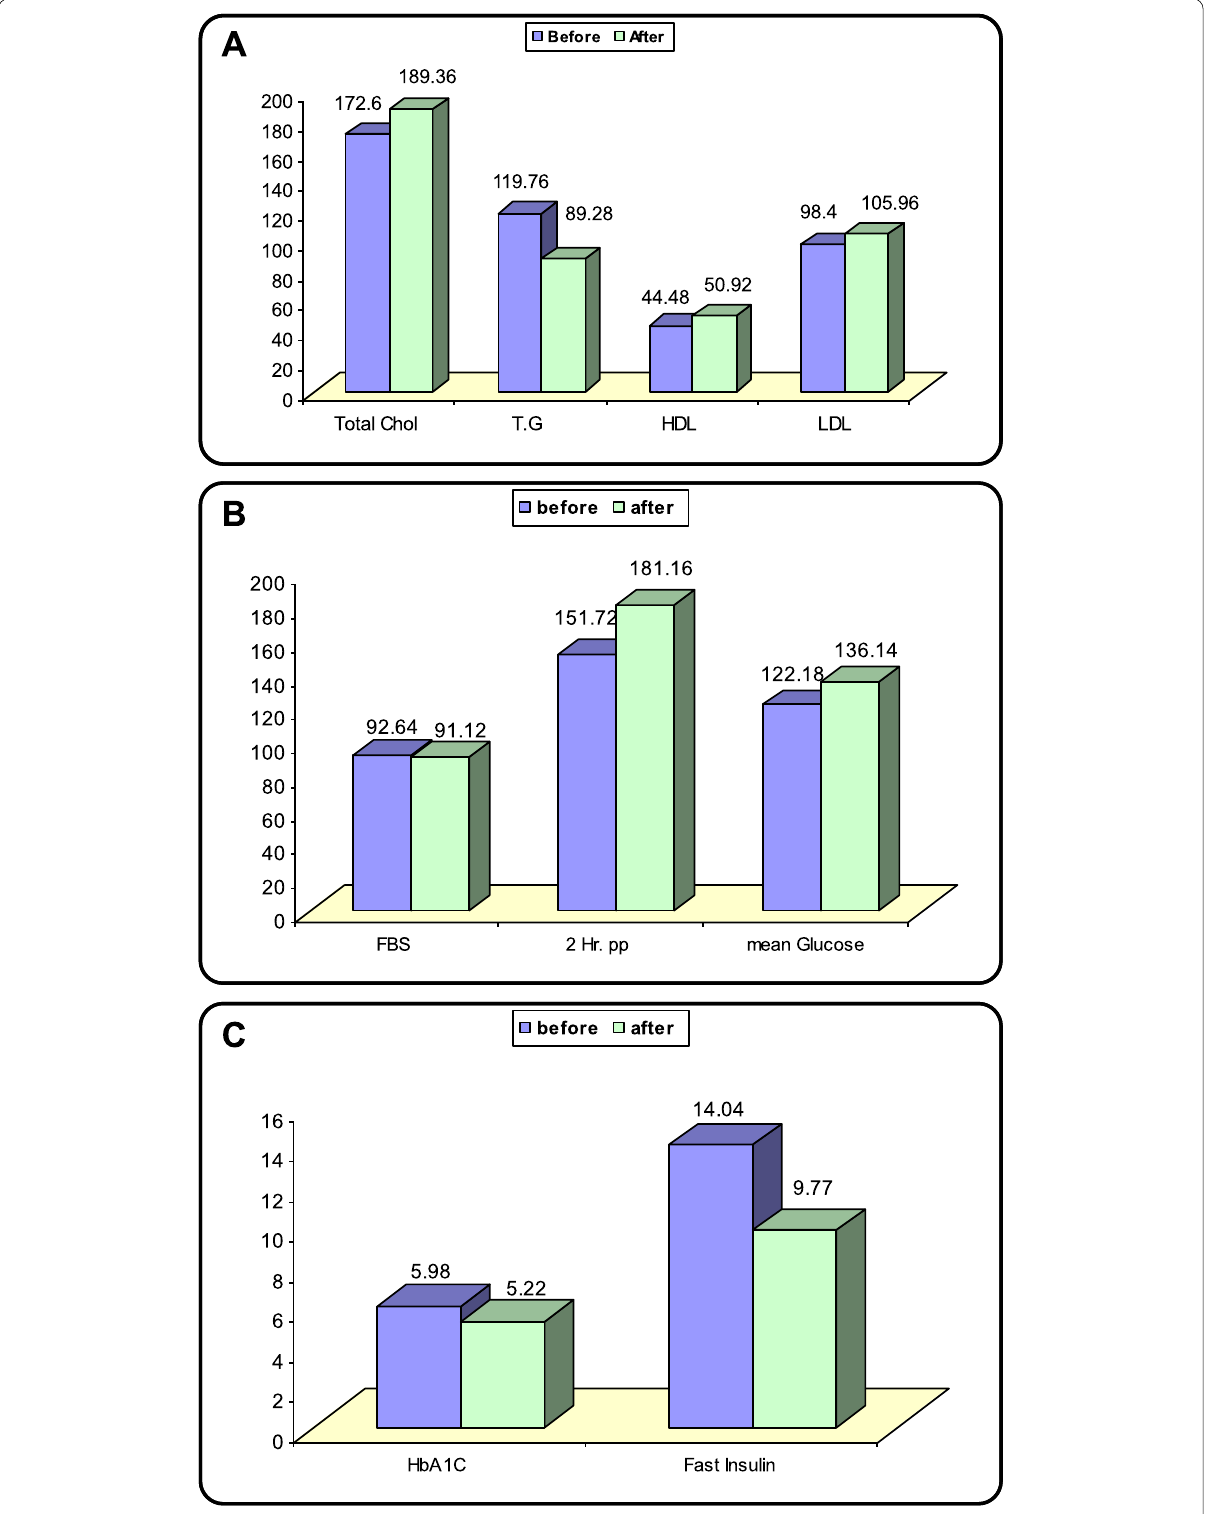
Fig. 2 A Comparison between lipid profiles at baseline and after SVR at 12 weeks among patients in group A. B Comparison between FBS, 2‑h postprandial blood glucose, and mean glucose levels at baseline and after SVR at 12 weeks among patients in group A. C Comparison between HbA1C and fasting serum insulin levels at baseline and after SVR at 12 weeks among patients in group